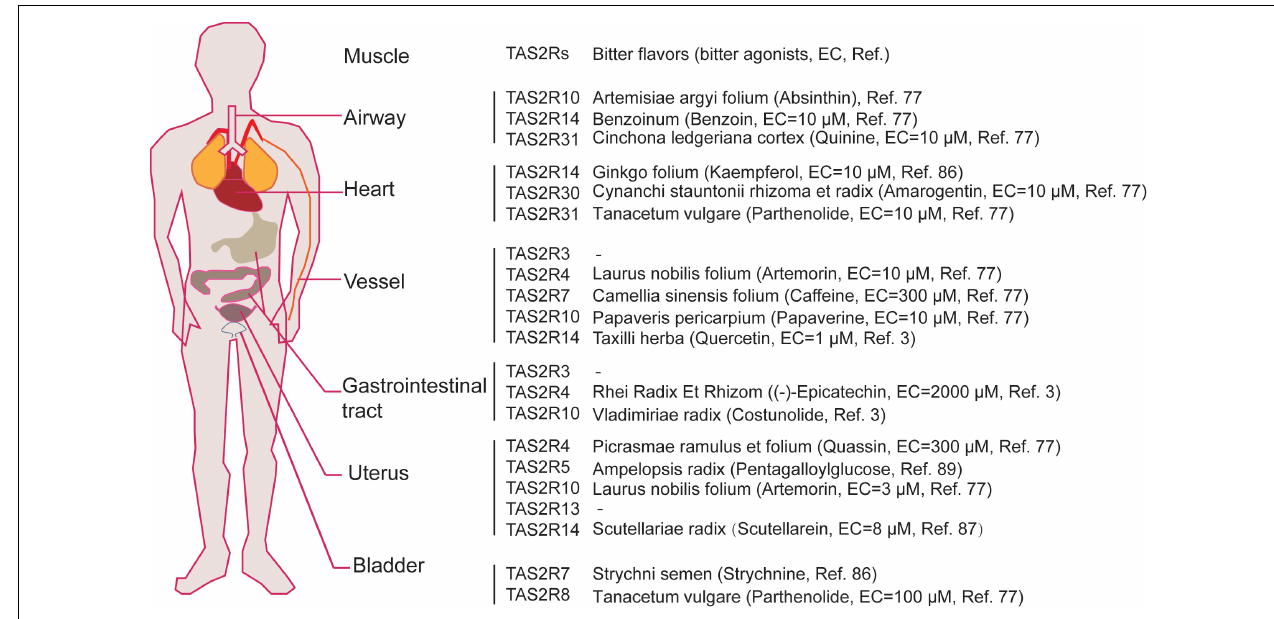
FIGURE 2 | The expression map of TAS2Rs in different muscle tissues which can be activated by bitter components from bitter flavored TCM. EC represents efficiency